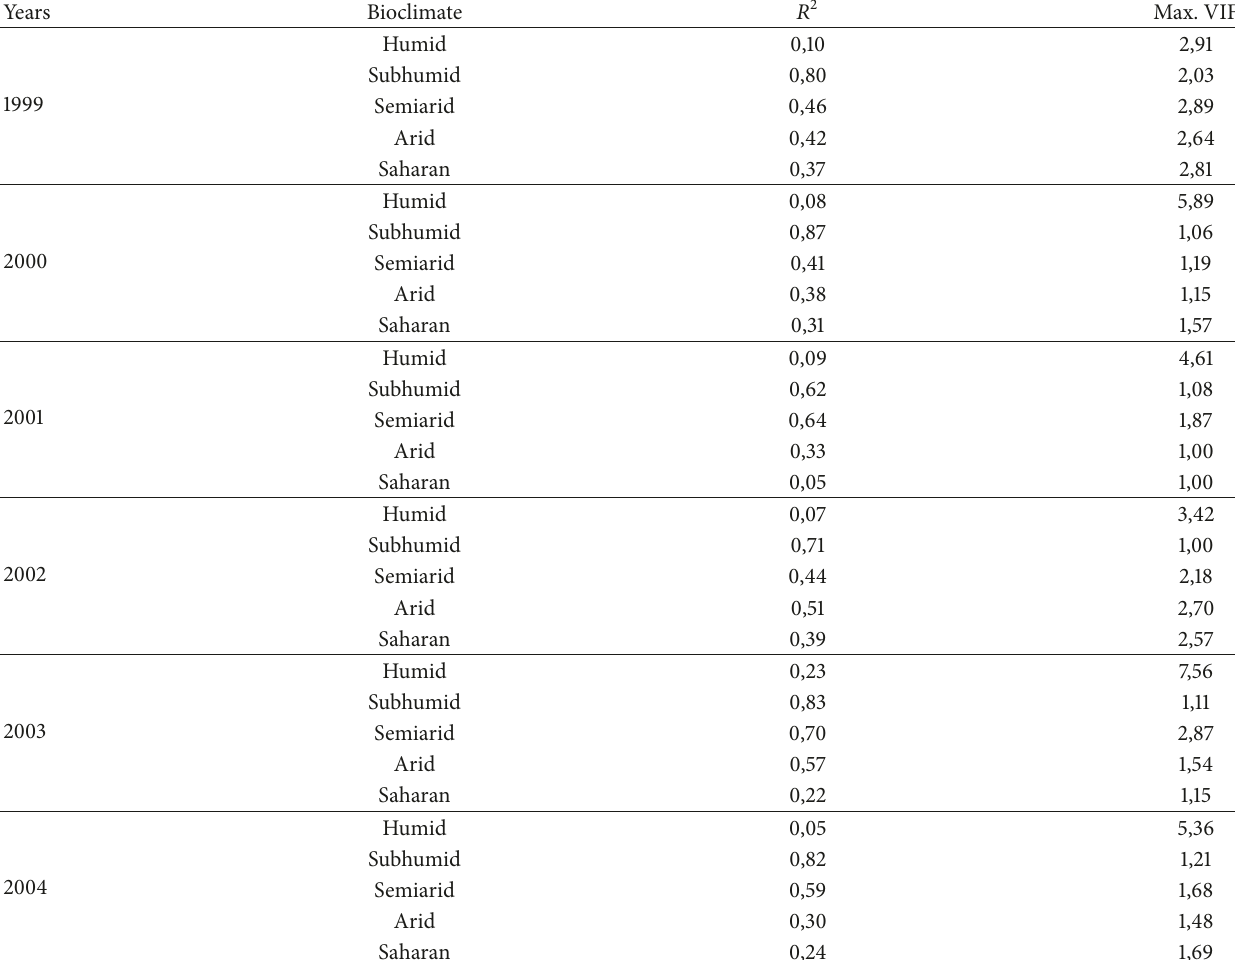
Table 6: Correlation parameters of the five bioclimatic stages during the six years.